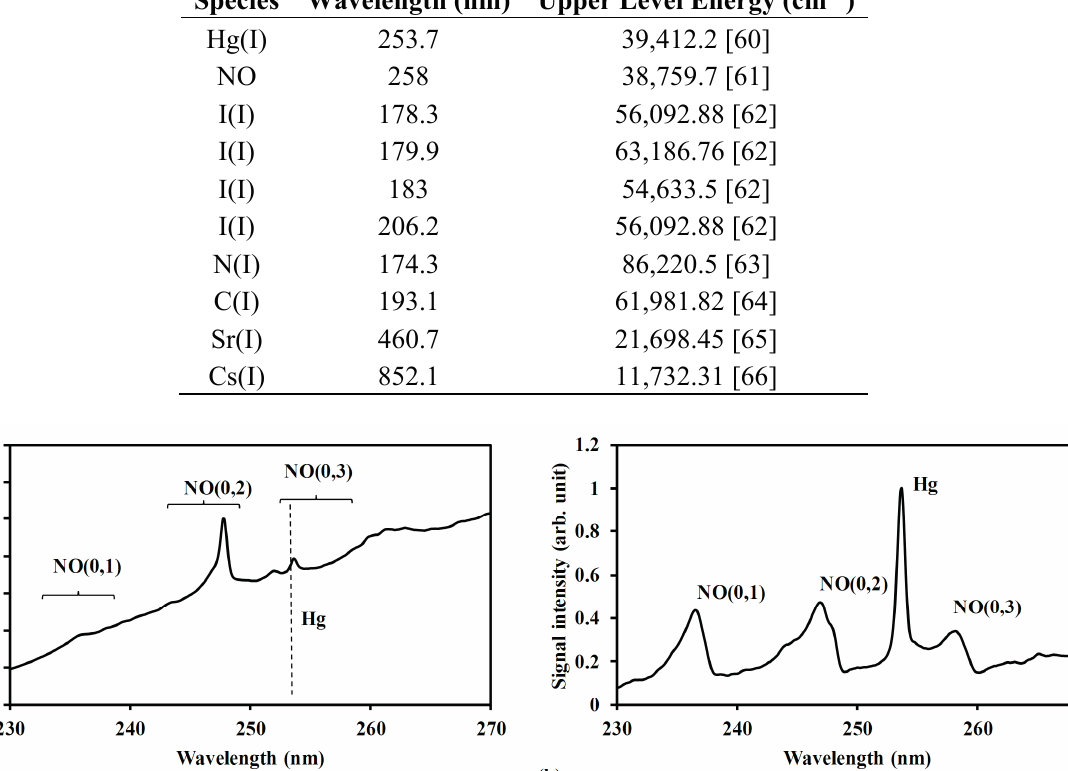
Figure 5. LIBS spectra of Hg in air at different pressure. ( a ) Pressure 30 kPa. Conditions: ns 1064 nm laser irradiation, delay time 2060 ns, power 600 mJ/p, beam diameter 9 mm,